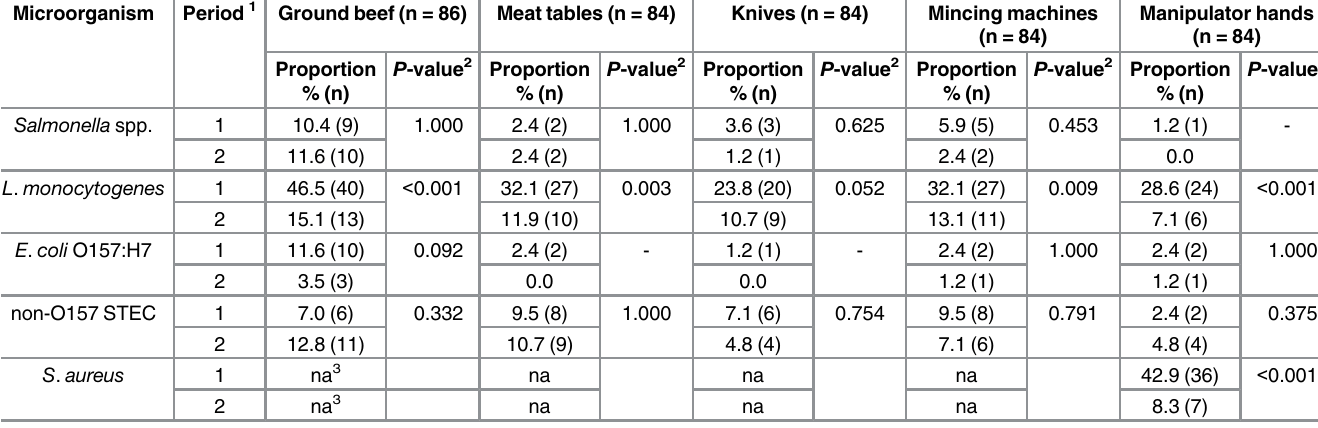
Table 3. Salmonella spp., L . monocytogenes , E . coli O157:H7, non-O157 STEC and S . aureus isolated from ground beef and environmental sam- ples of butcher shops in the evaluation (2010 – 2011) and verification (2013) periods. Microorganism Period 1 Ground beef (n = 86)